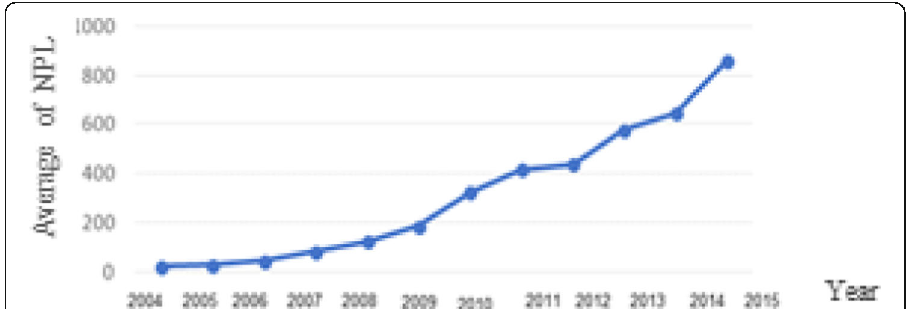
and the NPL increased. The vertical axis shows the average of NPL and the horizontal axis shows the